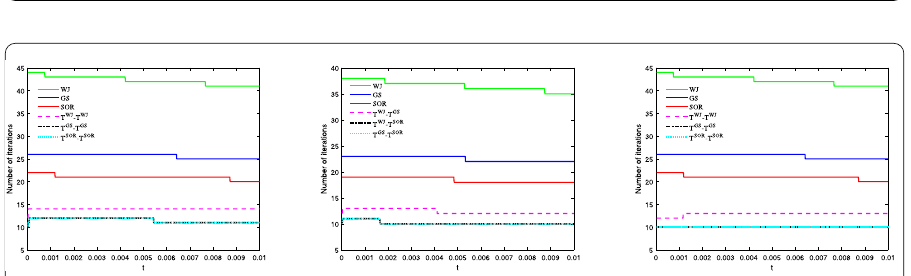
Figure 2 The evolution of iterations number for GS, WJ, SOR, and the proposed algorithm to problem (4.1) with β = 25 and t ∈ (0,1]